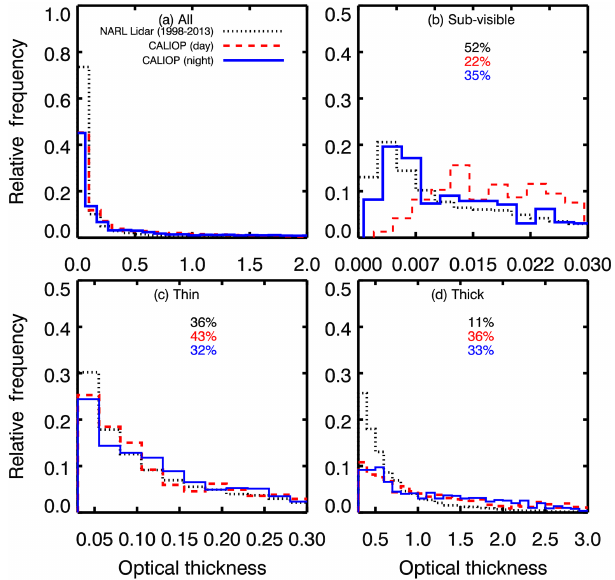
Figure 6. Histograms showing the frequency distribution of op- tical thickness of (a) all cirrus cloud layers (bin-size = 0.1), (b) sub-visible cirrus ( τ <0.03, bin-size = 0.0025), (c) thin cirrus (0.03< τ <0.3, bin-size = 0.025) and (d) thick cirrus cloud layers ( τ >0.3, bin-size = 0.1) obtained from NARL Lidar (dotted black line), CALIOP daytime (dashed red line) and CALIOP night-time (solid blue line) data sets. Percentage mentioned in each panel is in the same order as legend in (a) .